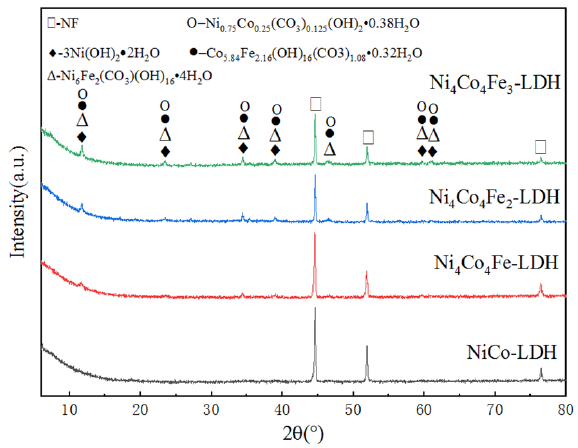
Figure 1. XRD patterns of the as-prepared samples.